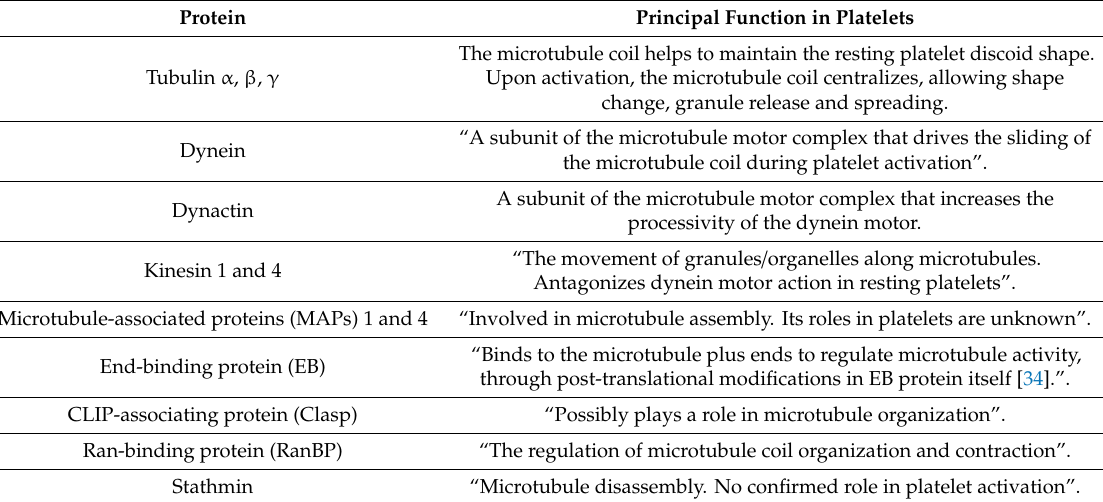
Table 2. Major platelet microtubule- interacting